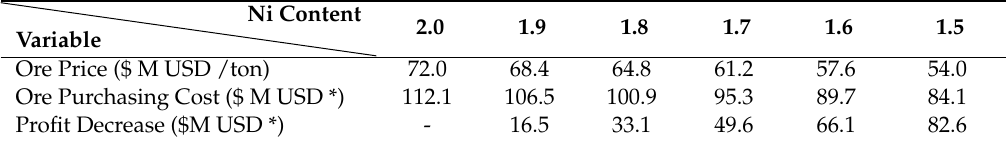
Table 5. Cost and profit with Ni content variation (constant price